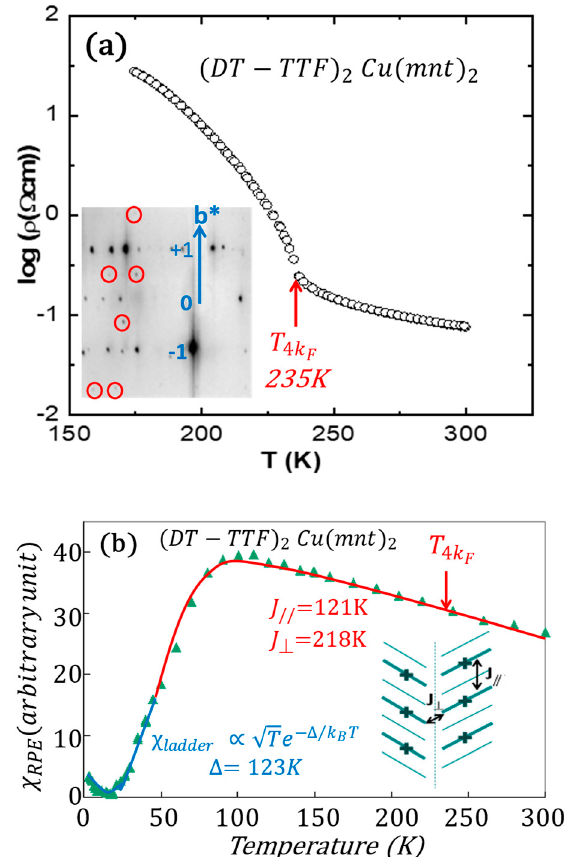
Figure 9. Thermal dependance of the logarithm of the resistivity ( a ) and of the RPE spin susceptibility ( b ) of DTTTF 2 -Cu(mnt) 2 (data originally published in ref. [41,42], respectively, are kindly provided in a modified form by M. Almeida). The b*/2 superlattice reflections appearing below T 4 k F are shown (red circles) in the X-ray pattern of the insert of figure ( a ). The thermal dependance of χ RPE if fitted at high temperature by χ spin of the frustrated ladder (red curve) with J ┴ and J // is represented in the figure, and at low temperature by χ ladder (blue curve), whose analytical expression is given. In ( a ), the weak increase of resistivity on approaching T 4 k from higher T could be due to the development of a pseudo-gap, due to 4k F fluctuations in the metallic state.